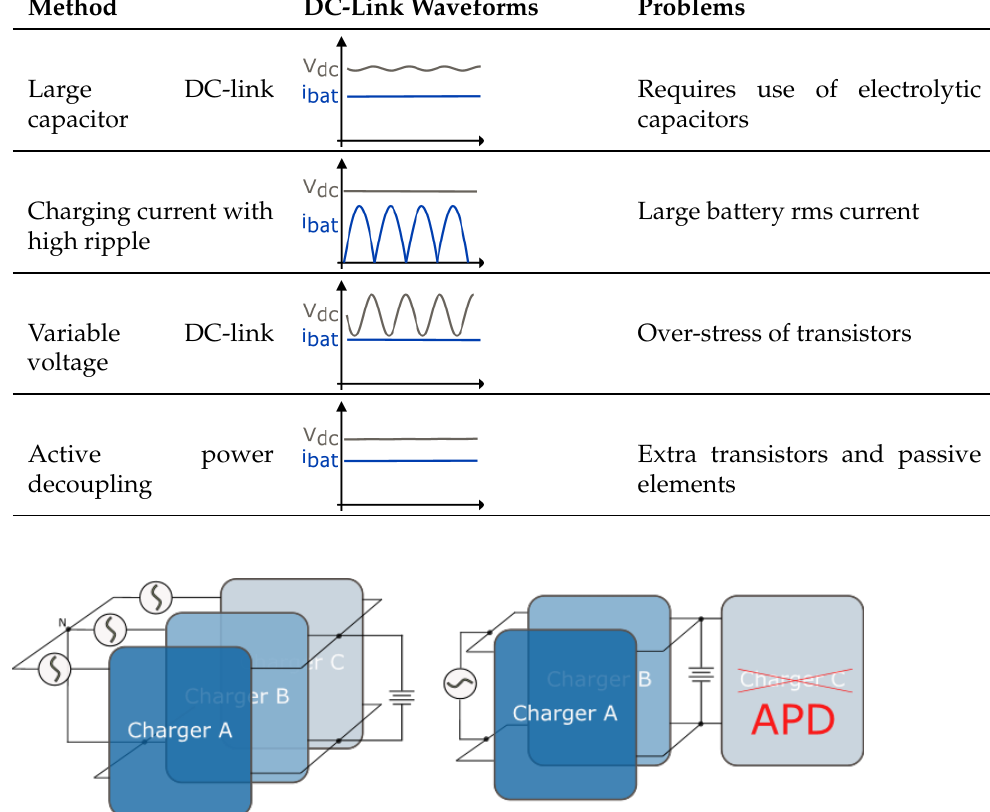
Table 5. Techniques to resolve the double-line frequency power pulsation (derived from [114,115]) .